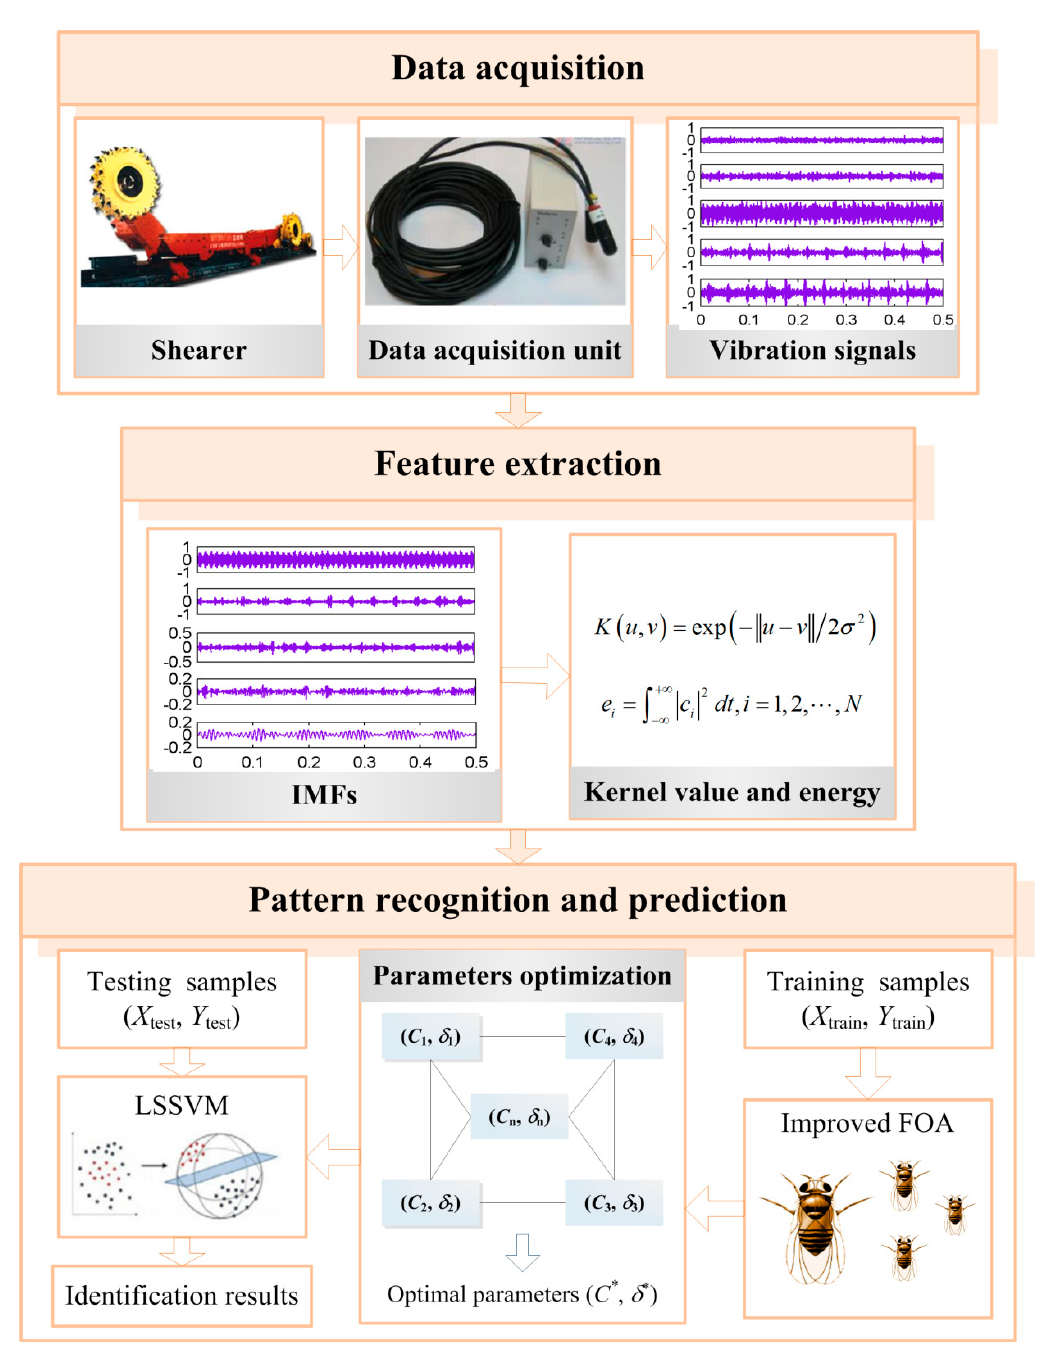
Figure 3. The identification system for shearer cutting pattern based on proposed method.